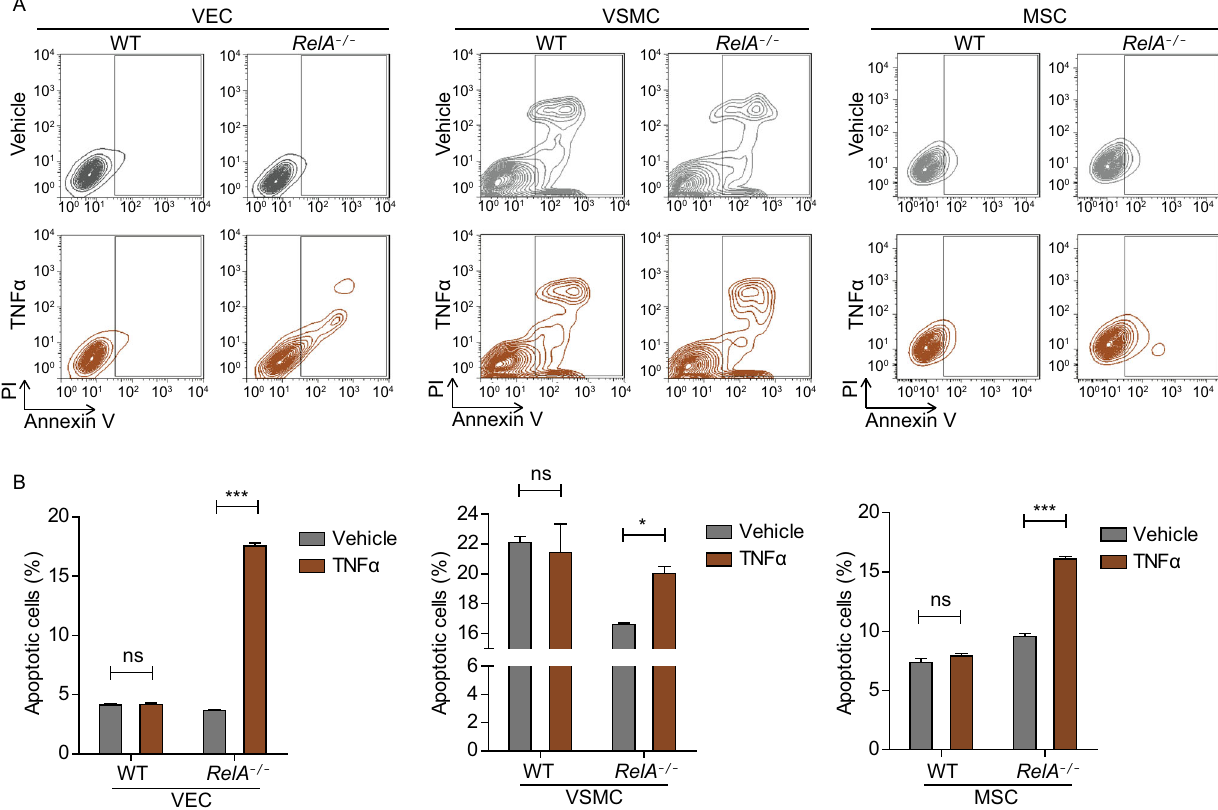
Figure 6. RelA de fi ciency promoted TNF α -induced apoptosis. (A) Flow cytometric analysis of apoptotic vascular cells under basal and 10 ng/mL TNF α -induced conditions. (B) Statistical analysis of apoptotic cells in WTand RelA − / − VECs, VSMCs, and MSCs upon 10 ng/mL TNF α treatment ( n = 3). ns, not signi fi cant; * P < 0.05; *** P <